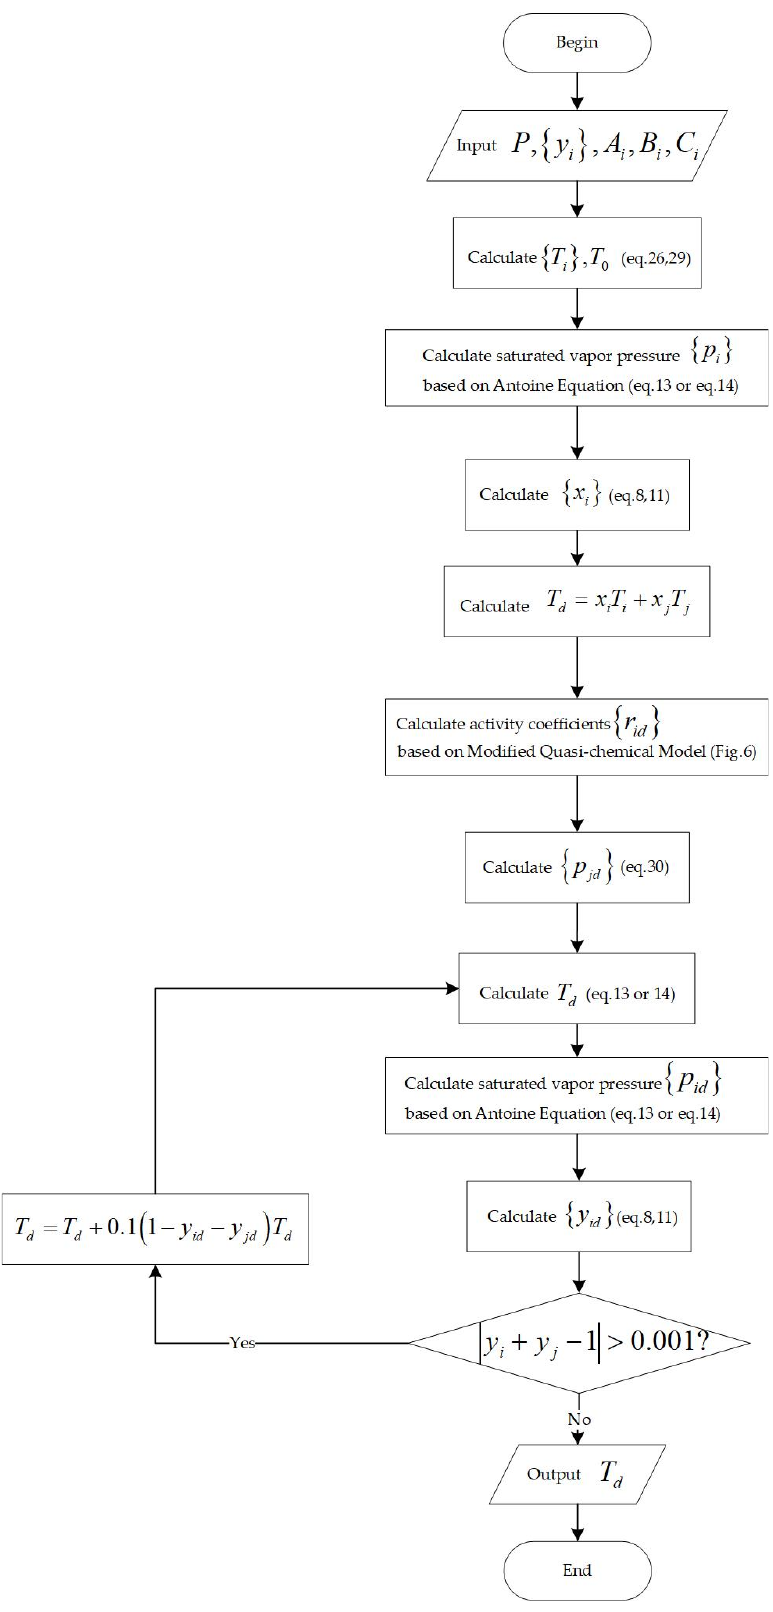
Figure 5. Flowchart for the calculation of dew point temperature.